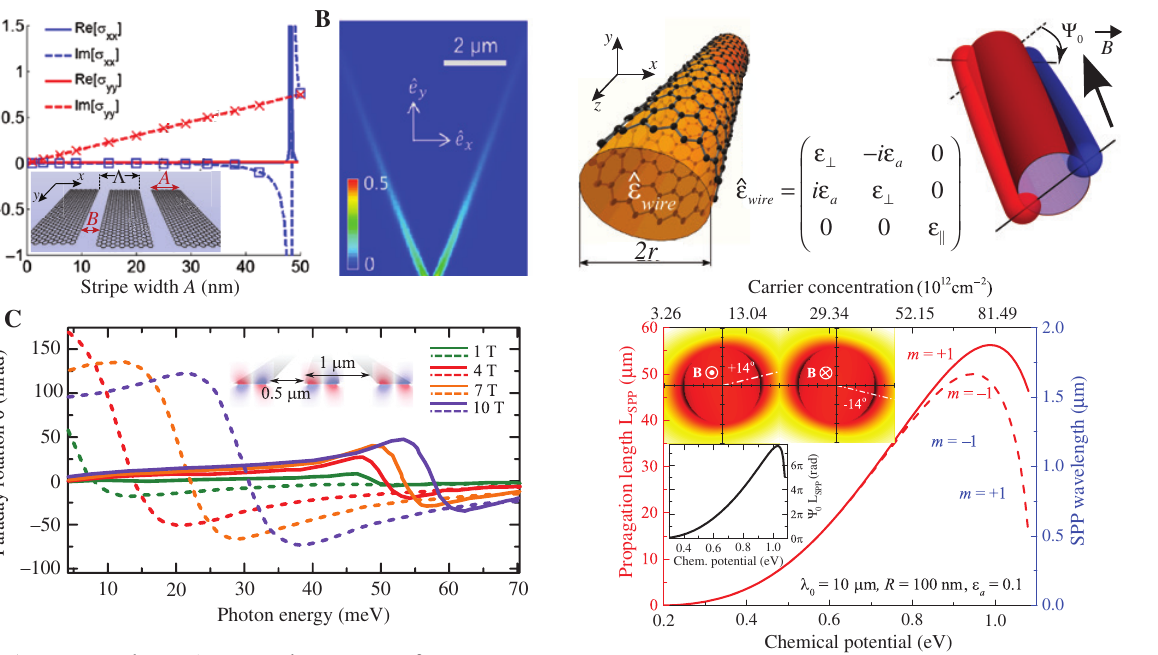
Figure 7: A magneto-optical nanowire covered with a graphene layer supports high-order azimuthal SPP modes with | m | > 0. Both the SPP propagation length (left axis) and wavelength (right axis) for the first-order mode with | m | = 1 depend on graphene chemi- cal potential (corresponding carrier concentration is shown on the top axis). Core radius r = 100 nm, frequency of electromagnetic = 10 μ m), permittivity of the wave f = 30 THz (vacuum wavelength λ 0 = ε = 3, gyration of the core ε = 0.1. The outer medium is in core ε ⊥ || a vacuum. In the upper inset, the field distributions are shown for the = 500 nm and μ = 1 eV. Total opposite magnetic field directions at z 0 ch rotation of the field distribution upon the reversal of the external = 0.1 at magnetic field with B ≈ 1.8 T (such magnetic field leads to ε a Verdet constant V = 10 4 rad T −1 m −1 ) pointing along the nanowire axis is about 28 ° . The lower inset shows the figure of merit, i.e. the rota- tion angle per propagation length. Adapted from [48].